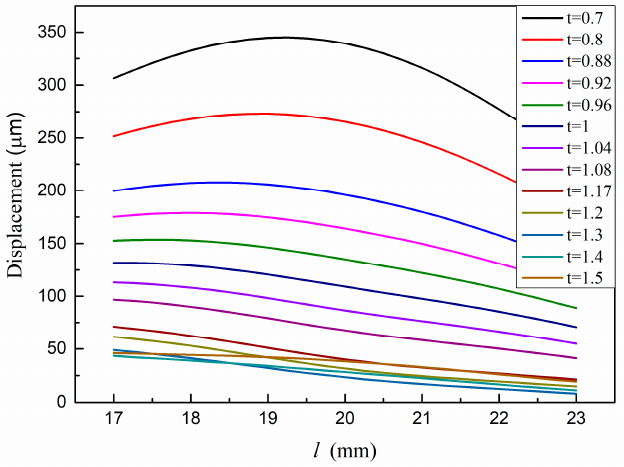
Figure 6. Displacement of the driving end versus structural parameters.